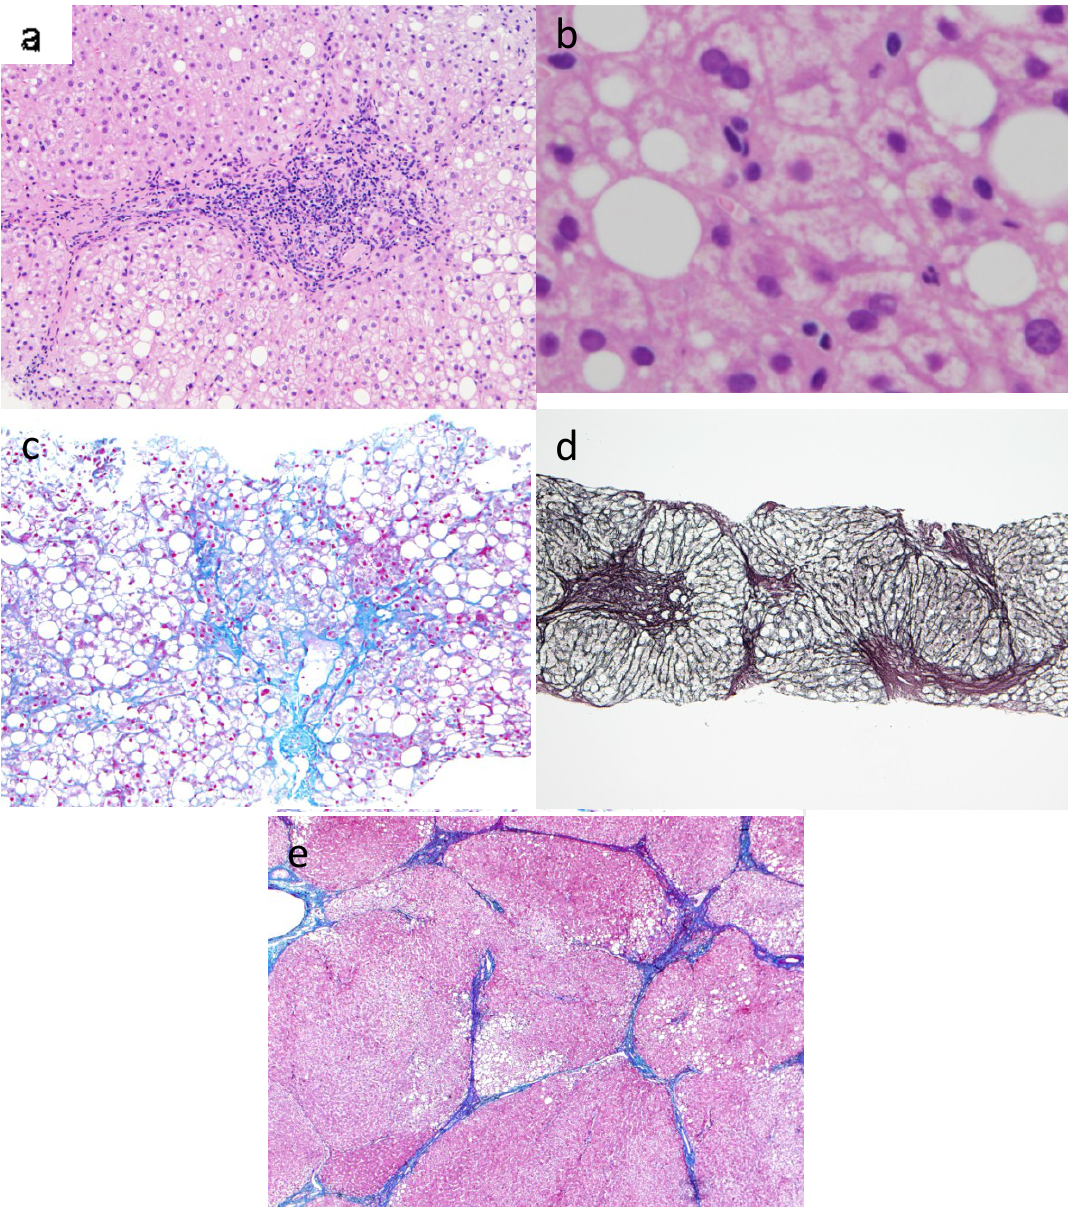
Figure 1. Histological features of the different steps of fibrosis in NASH. ( a ) NASH: Steatosis, hepatocyte balooning degeneration, and inflammatory cells composed predominantly of lymphocytes in the portal area (Hematoxylin-eosin stain, 200× magnification); ( b ) Mallory body in NASH showed staghorn pattern (Hematoxylin-eosin stain, 400× magnification); ( c ) NASH: Detail of wire-mesh fibrosis and steatosis (Azan stain. 100× magnification); ( d ) Bridging fibrosis: Portal-central fibrous septa linking portal tracts and central veins (Reticulin silver stain, 40× magnification); ( e ) NASH-derived cirrhosis: Larger nodules with thin fibrous septa and steatosis (Azan stain. 40×